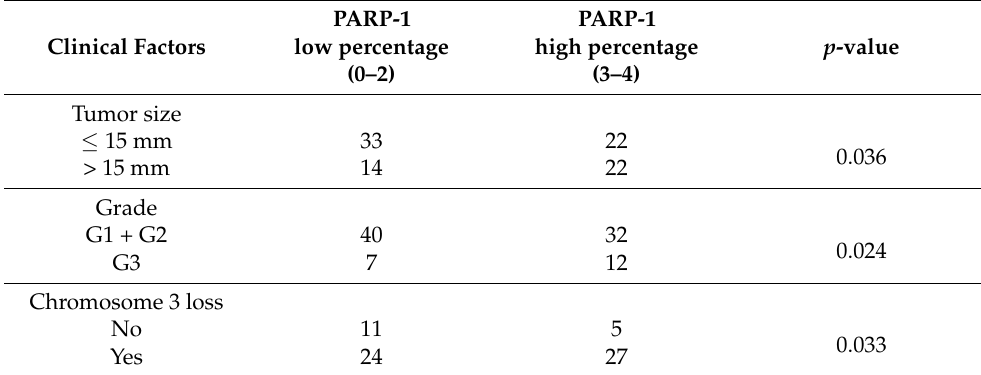
Table 4. Statistically significant correlations of percentage of positive cells with clinicopathological